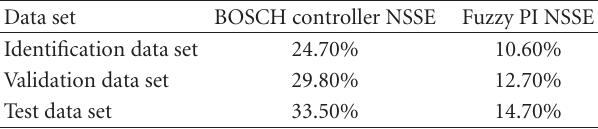
Table 2: Performances of the simulated